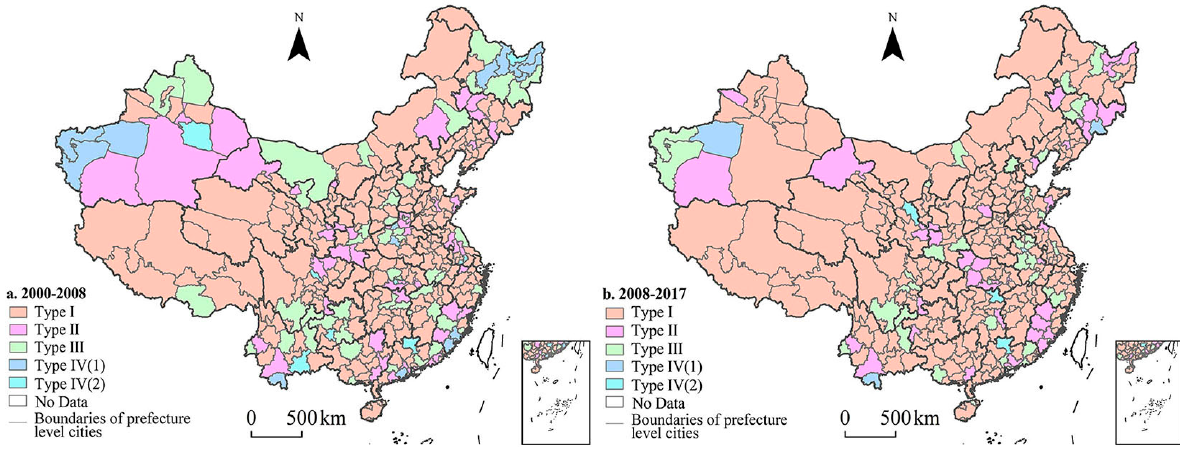
Figure 5. LISA Spatiotemporal transition of USI in China.